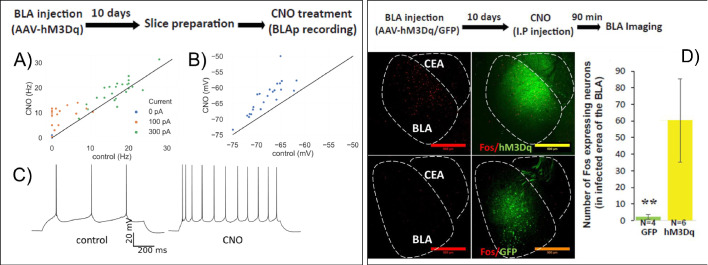
HM3Dq DREADD increases BLA activity.(A–C) Whole-cell patch clamp recordings from BLA neurons in acute brain slices following in vivo infection with AAV-CamKIIa::HM3Dq. Firing rate (A), example in C) in response to 1 s current steps and resting membrane potential (B) measured before (control) and 5 min after (CNO) bath application of 0.1 µM CNO. (A) A repeated measures ANOVA revealed a significant main effect of CNO application (F(1,27) = 22.9, p=5.4 E-5) and current (F(2,54) = 355.4, p=8.3×10−32) on firing rate, along with a statistically significant interaction (F(2,54) = 8.2, p=2.57×10−11). Post-hoc pairwise comparisons showed that firing rates of neurons were significantly higher during the CNO treatment compared to control in response to 100 pA (p=5×10−7) and 300 pA (p=0.012) input. (B) Resting membrane potentials of neurons are significantly higher than in control (paired sample t-test, t = −8.5, p=2×10−8). (C) Sample trace of spike trains in current clamp with 100 pA stimulation of the same neuron in CNO and control conditions. (D) BLA was infected with AAV-CamKIIa-HM3Dq or GFP as control. 10 days later mice were injected with CNO and C-FOS protein expression in the infected area in the BLA was measured 90 min later. Left. Representative images of C-FOS/HM3Dq and C-FOS/GFP. Right. CNO treatment increases C-FOS expression in the infected area in the BLA (N = 4/6; Mann–Whitney: Z = − 2.76; p=0.006). **p<0.01.